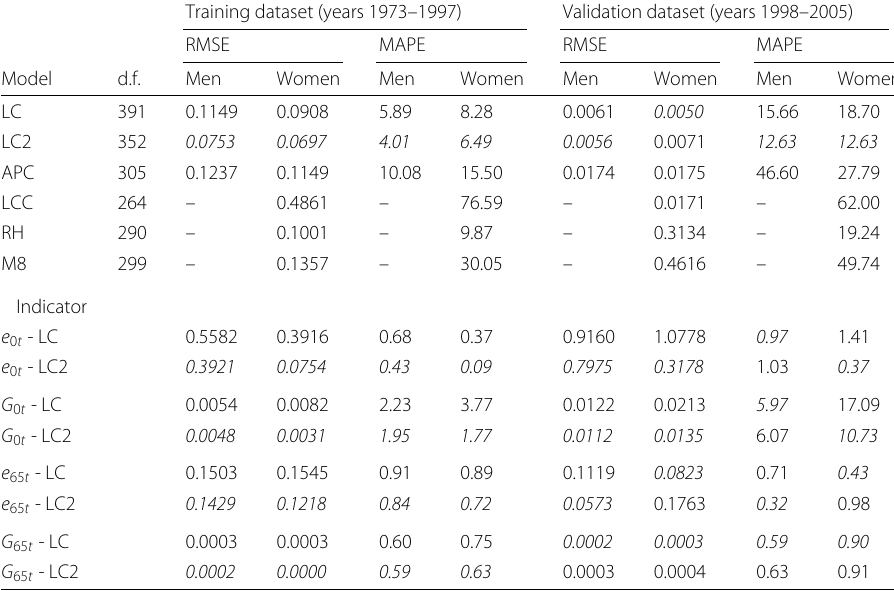
Table 2 Measures of goodness of fit for the fitted models and mortality indicators Training dataset (years 1973–1997) Validation dataset (years 1998–2005)